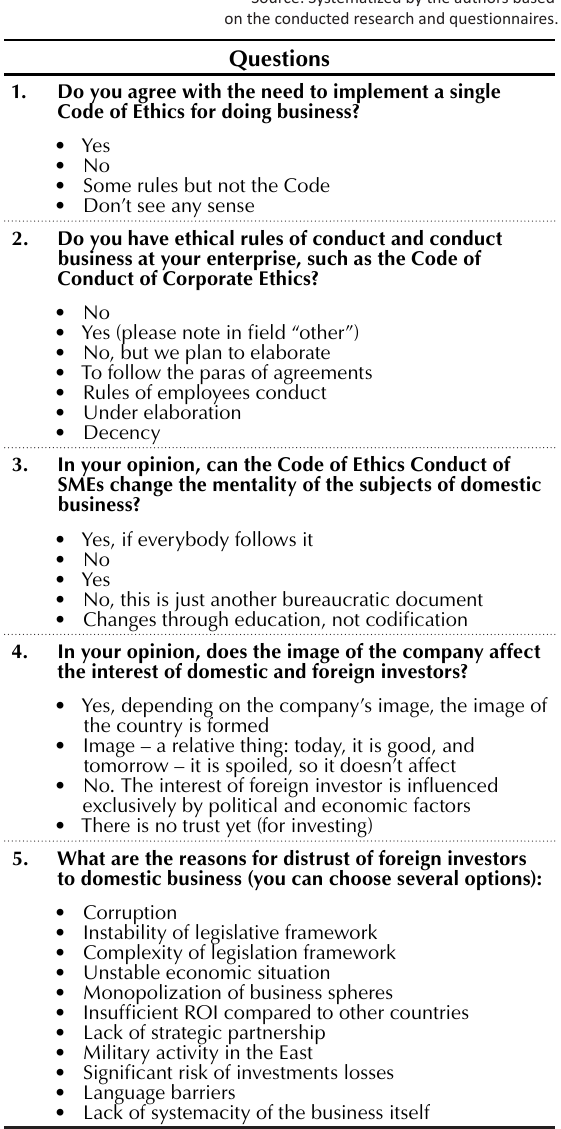
Table 1. The list of questions of marketing research on the theme “Necessity of the Code of Ethics implementation for the Management of Small and Medium-Sized